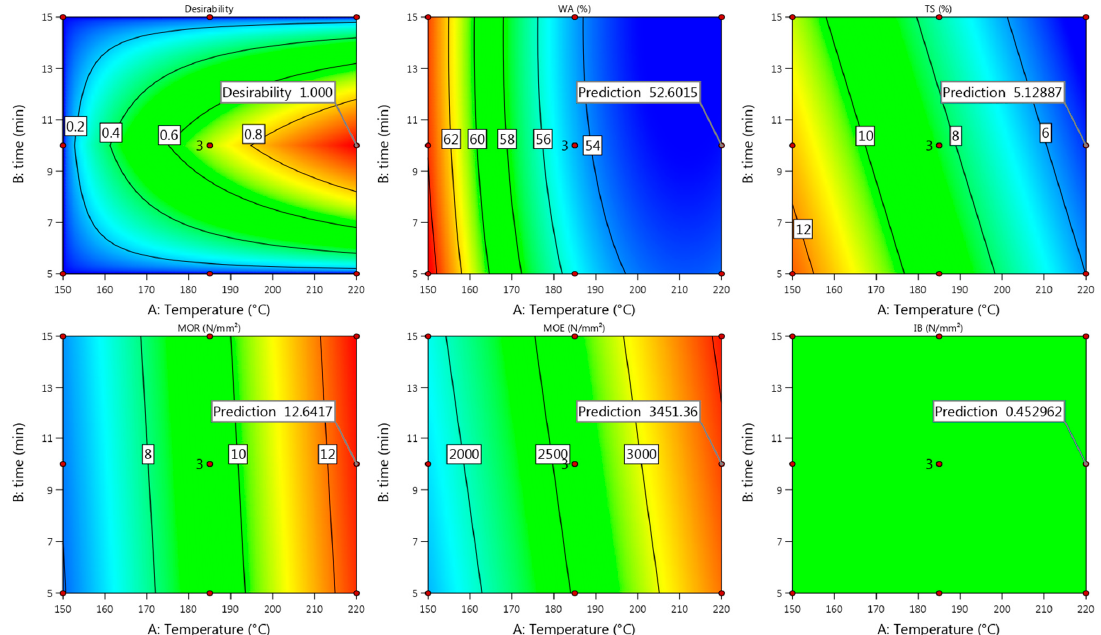
Figure 5. Contour plots with predicted values of Uso-800 binder-less board properties at T = 220 °C and t = 10 min.